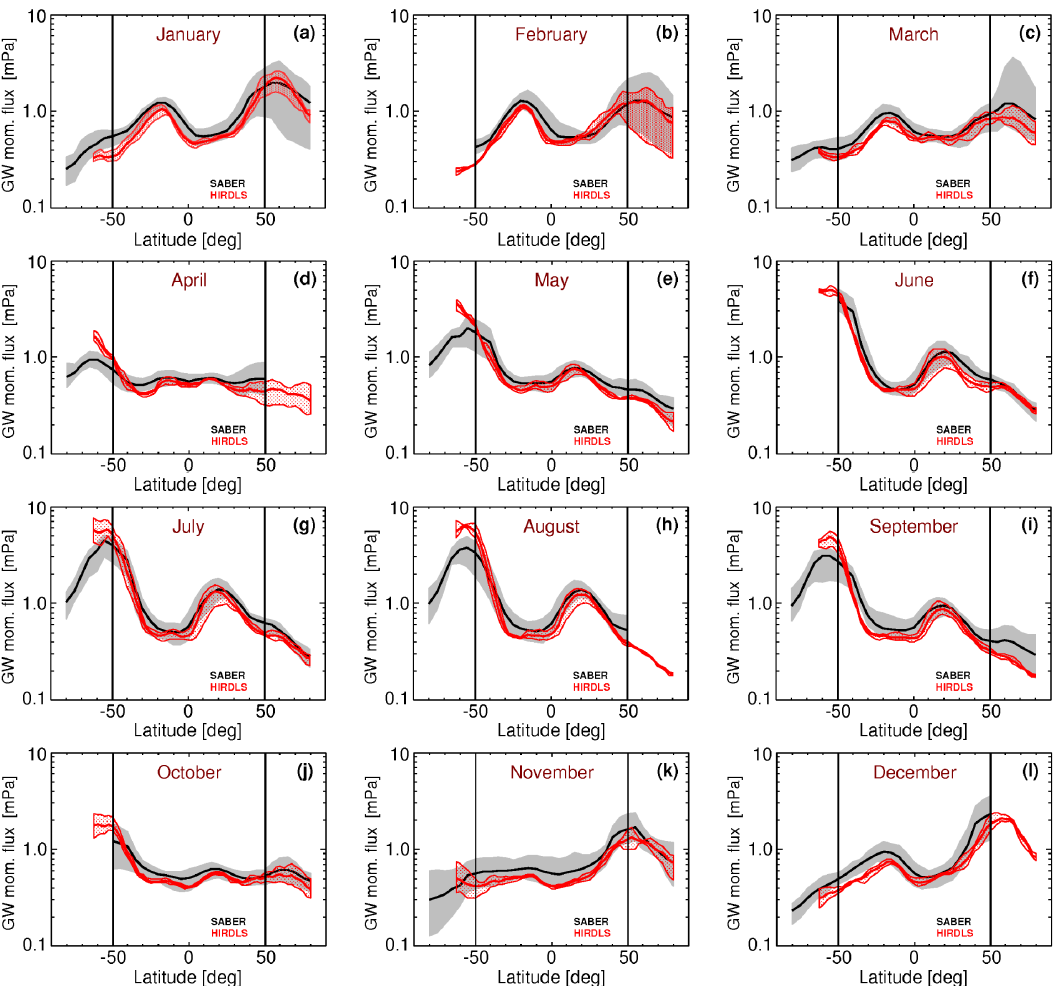
Figure 18. Zonal-average gravity wave momentum fluxes at 30km altitude. Shown are climatological averages for each calendar month (solid lines), as well as shaded envelopes that indicate the range of natural variability during the respective time period considered. SABER values are in black, and HIRDLS values are in red. The climatological averages are 13-year averages for SABER, and 3-year averages for HIRDLS, separately for each calendar month. Vertical lines at 50 ◦ S and 50 ◦ N indicate that only latitudes equatorward of 50 ◦ are continuously covered by